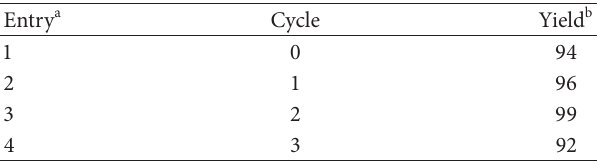
Table 2: Reusability of the catalysts in the